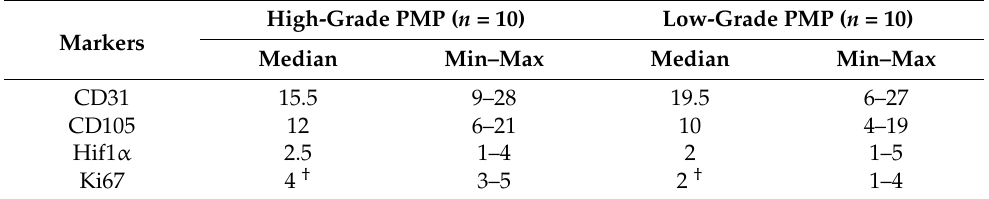
Table 1. Immunohistochemical analysis of tumor samples from pseudomyxoma peritonei (PMP) patients.